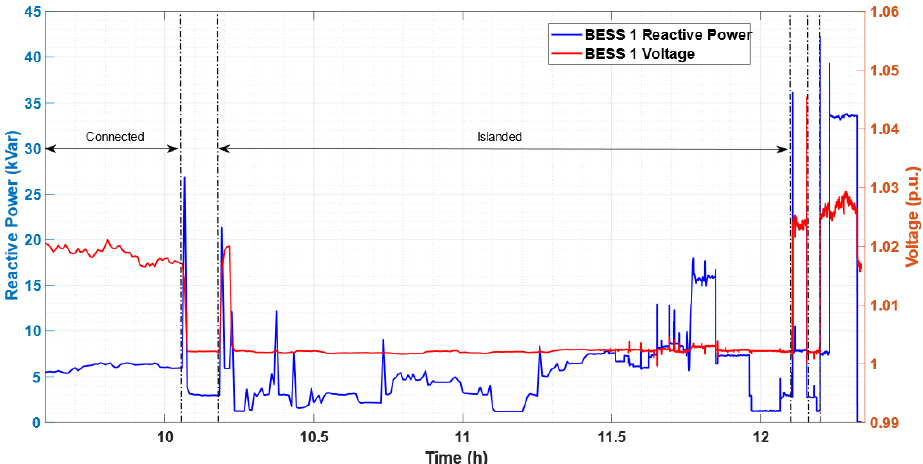
Figure 13. Voltage and reactive power of BESS